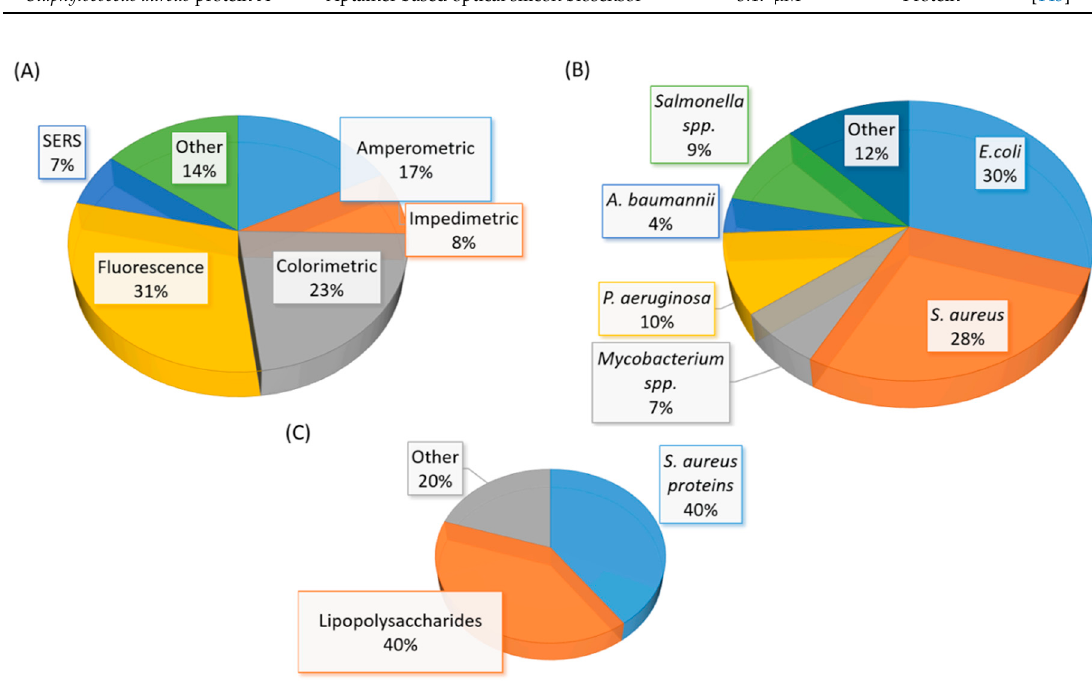
Figure 7. ( A ) A graphical representation of the type of aptasensor summarized in Table 3. ( B ) A graphical representation of the whole-cell bacterial species detected in Table 3. ( C ) A graphical representation of the types of bacterial component detected in Table 3. The total number of